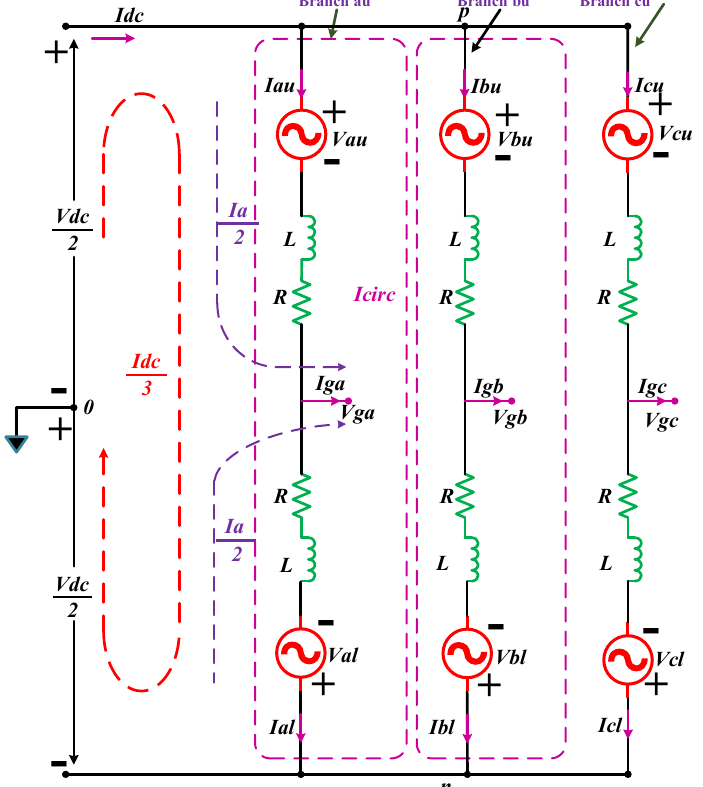
Figure 10. Threephase equivalent circuit of MMC.